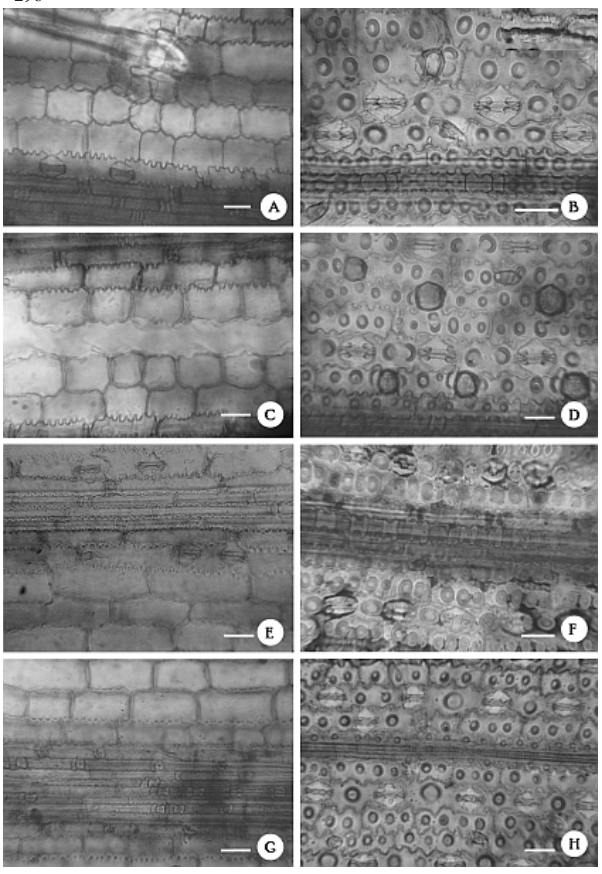
Fig. 4. Photomicrographs of leaf-blades: A, B: Ischaemum tra- vancorense ; C, D: Sehima nervosum; E, F: S. sulcatum ; G, H: Triplopogon ramosissimus ; A, C, E, G: Adaxial epidermises; B, D, F, H: Abaxial